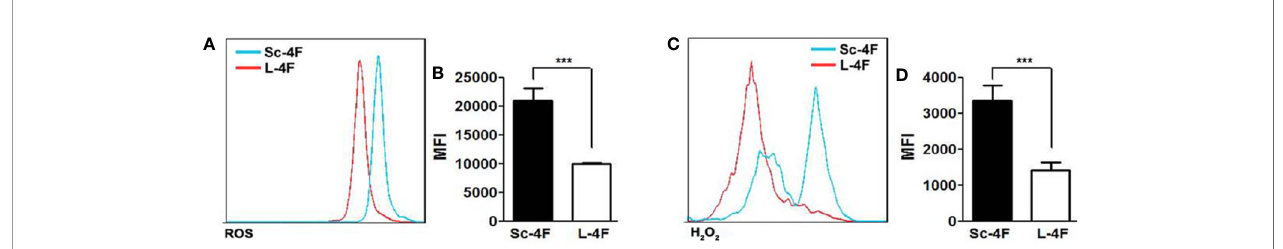
FIGURE 5 | L-4F inhibits the production of ROS by MDSCs MDSCs were isolated from the spleen and tumor tissue of Sc-4F or L-4F-treated mice using anti-mouse Ly-6G and Ly-6C particles-DM. The ROS activity and H 2 O 2 concentration were detected. (A, C) One representative result from each experiment is shown. The MFI of the ROS activity (B) and the MFI of the H 2 O 2 detection (D) in the isolated Ly6G + Ly6C + MDSCs (***P <